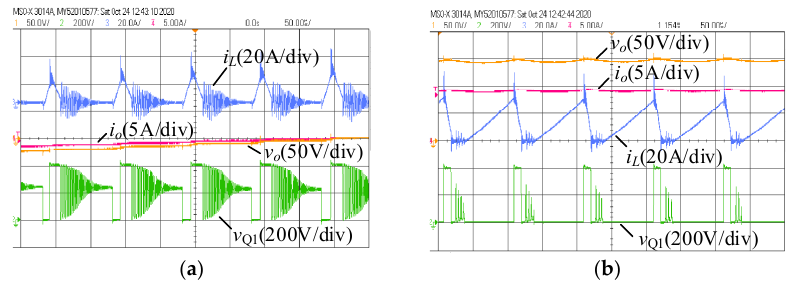
Figure 12. Waveforms of the active switch drain-source voltage and inductor current for the DCM operation at 1 kW: ( a ) v o = 0, ( b ) v o =150 V (time: 50 µ s/div).